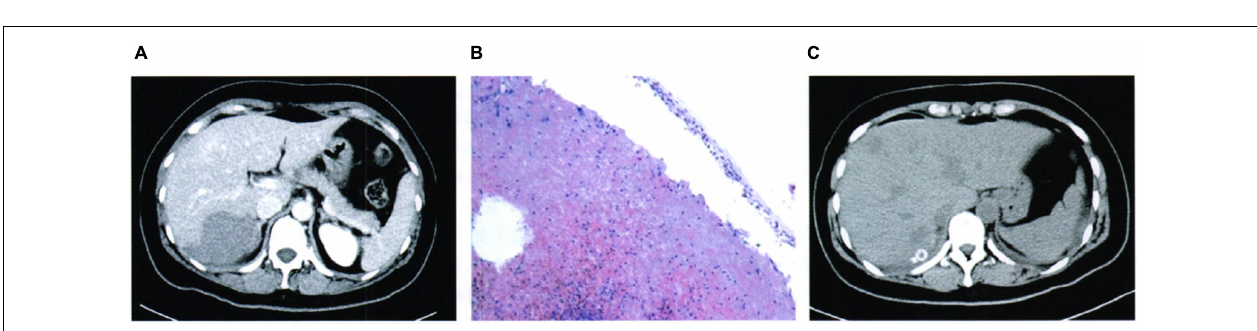
FIGURE 2 | Case 2: (A) Pre-operative imaging examination, (B) pathological findings, and (C) post-operative imaging